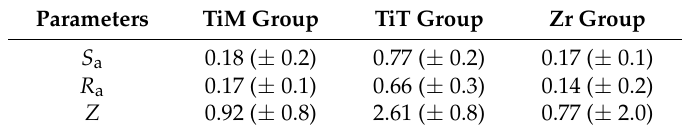
Table 1. Mean of roughness values S a and R a ( ± standard deviation) of both groups.